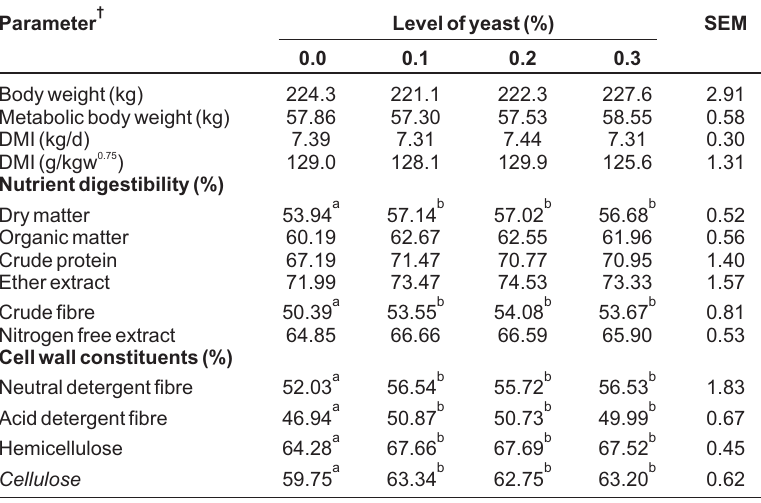
Nutrient proximate